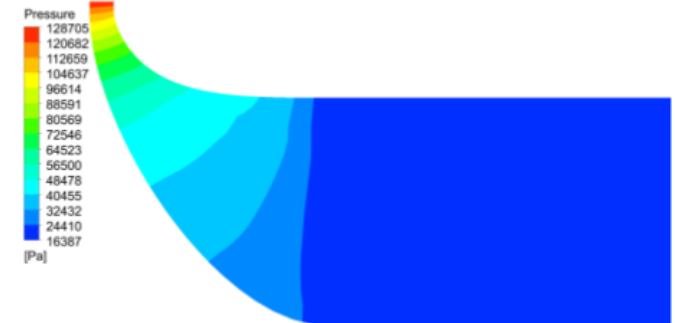
Figure 12: Static pressure in the rotor averaged along the circumference.